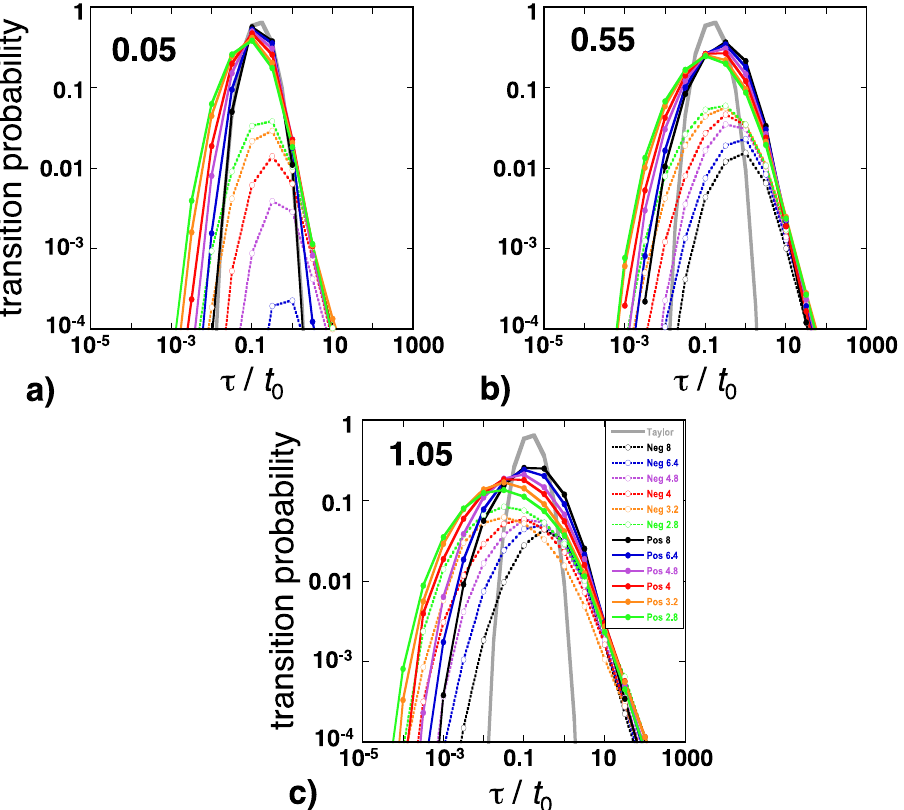
Figure 9. Transit time probabilities P + ( τ / t 0 ) (solid lines) and P − ( τ / t 0 ) (dotted lines) for BCC simulations with CV = 0.05 ( a ), 0.55 ( b ) and 1.05 ( c) . The curves corresponding to different values of Z are represented in colors as indicated in the inset. The thick grey curve in each diagram represents the theoretical transit time probabilities inferred from the Taylor dispersion transit time CDF (equation 1) with a velocity U and a dispersion coefficient D 0 . (See text for more